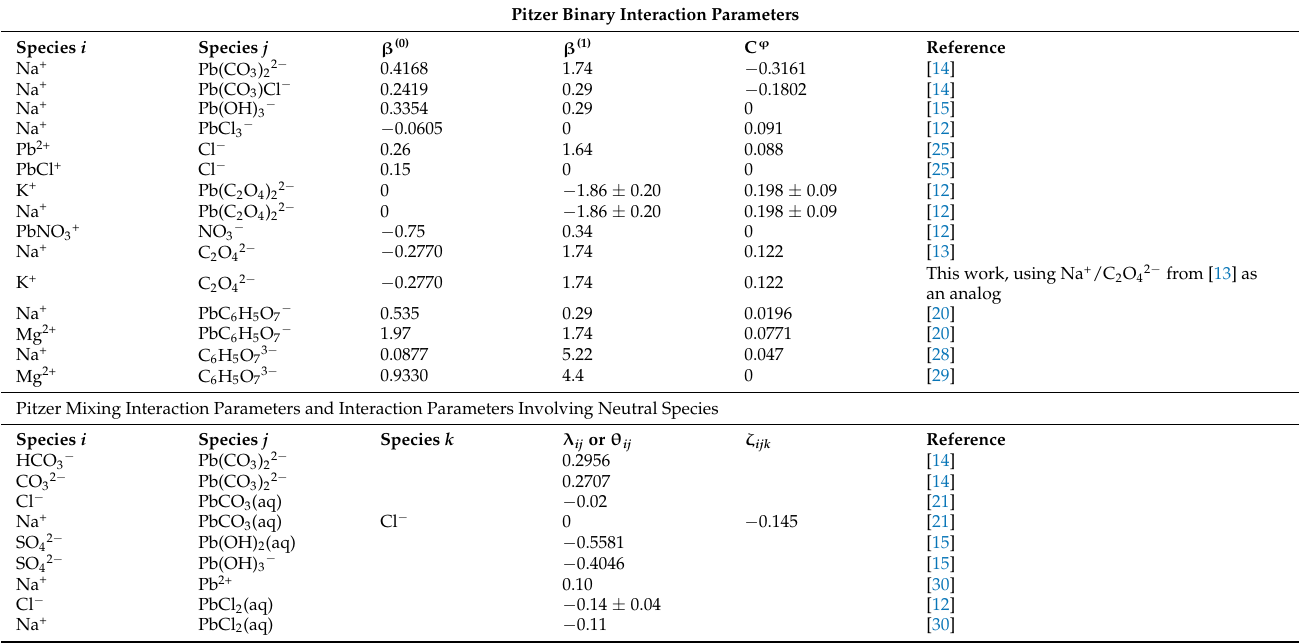
Table 2. Pitzer interaction parameters at 25 ◦ C and 1 bar for key chemical species relevant to recycling of lead pastes from lead–acid batteries via hydrometallurgical